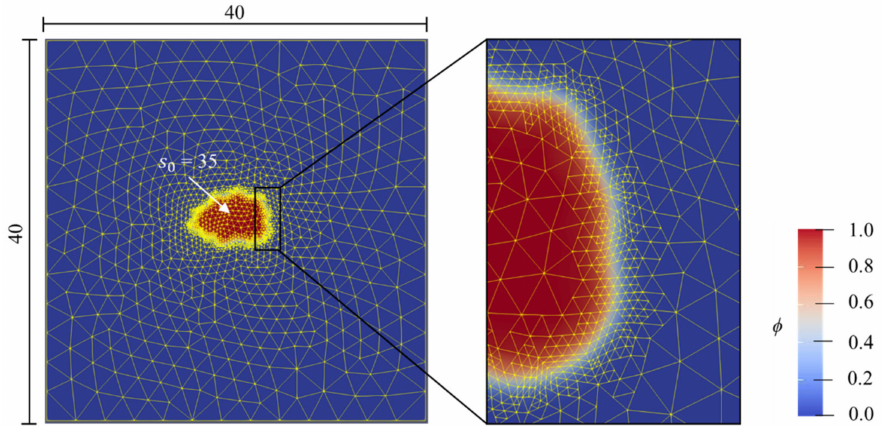
Figure 3. Adaptive mesh refinement in the simulation for mineral